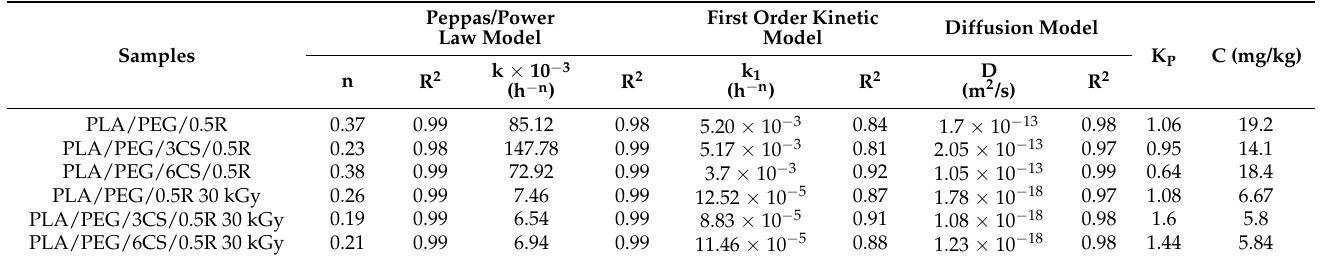
Table 5. Kinetic parameters of the migration of the active components of the rosemary extract into simulant D1 from plasticized PLA blends and biocomposites. Peppas/Power Law Samples